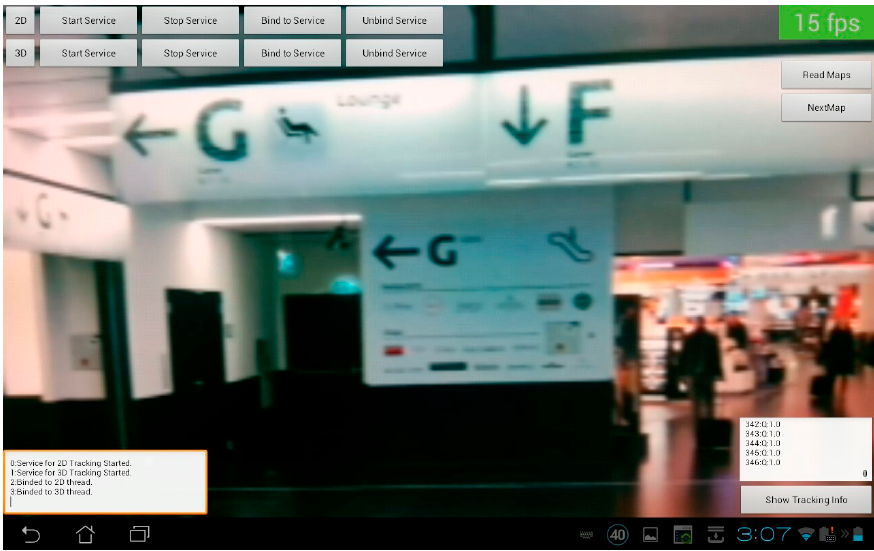
Figure 9. Screenshot of the tracking application.